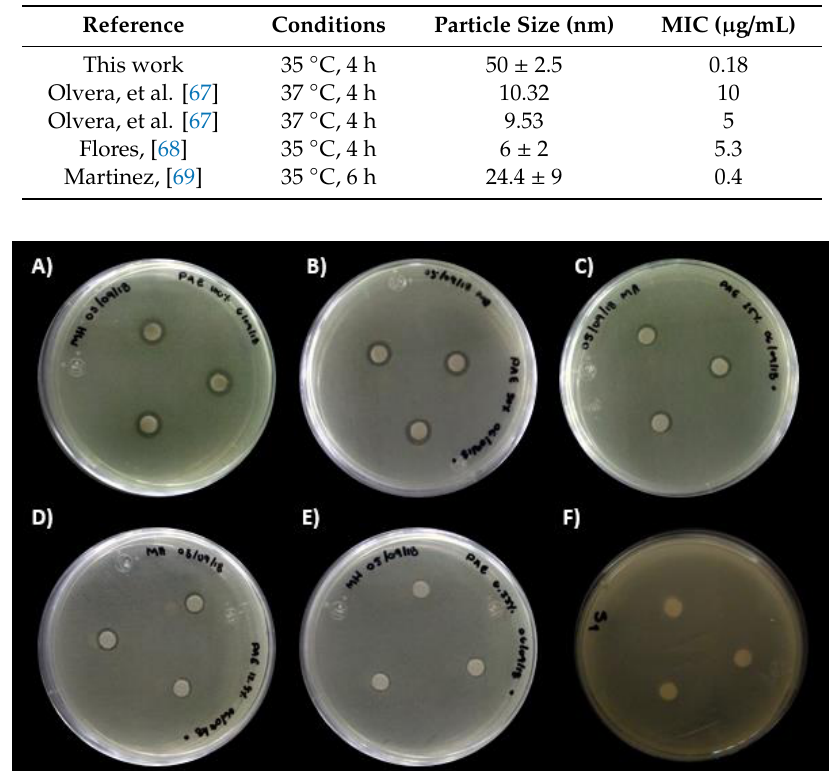
Figure 7. Inhibition halos of P. aeruginosa cultures at di ff erent AgNPs concentrations: ( A ) 0.72, ( B ) 0.36, ( C ) 0.18, ( D ) 0.09 and ( E ) 0.05 µ g / mL. ( F ) Control using distilled water.